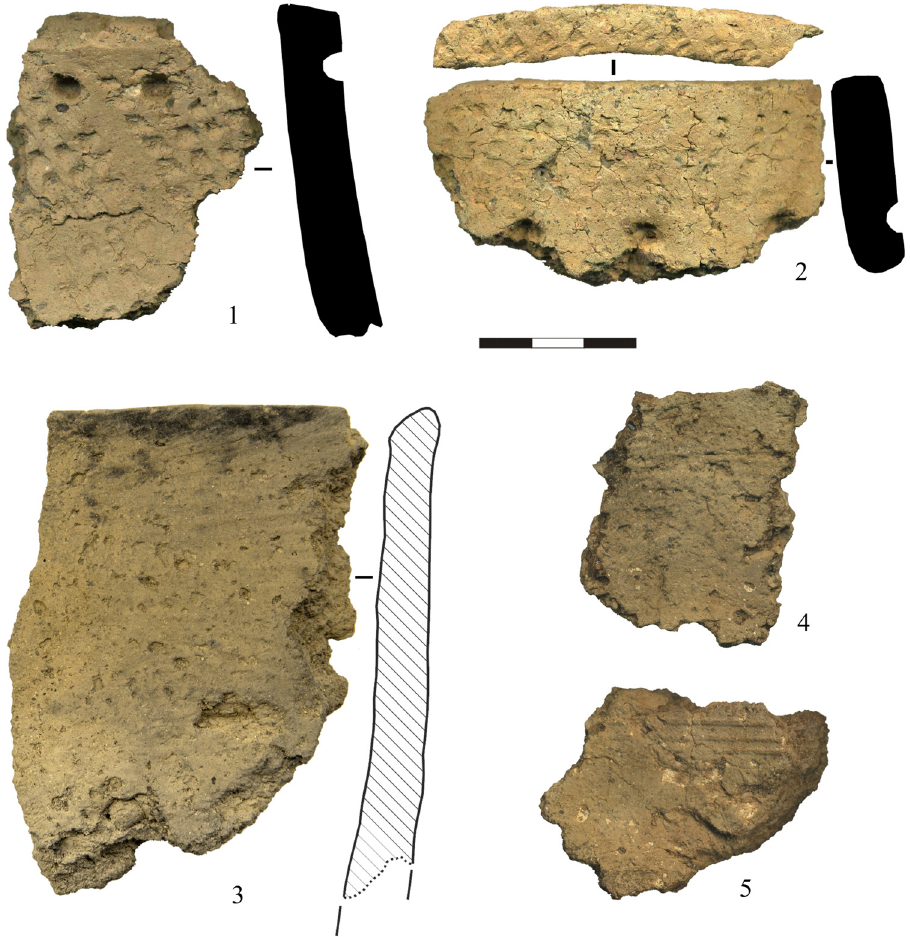
Figure 3: Early pottery from EGF: ( 1 and 2 ) Sperrings Ware from the Karelian Isthmus ( Komsomolskoye 3, MAE RAS ) ; ( 3 – 5 ) Narva Ware from the Narva - Luga Klint Bay area ( Kuzemkino 6, MAE RAS )